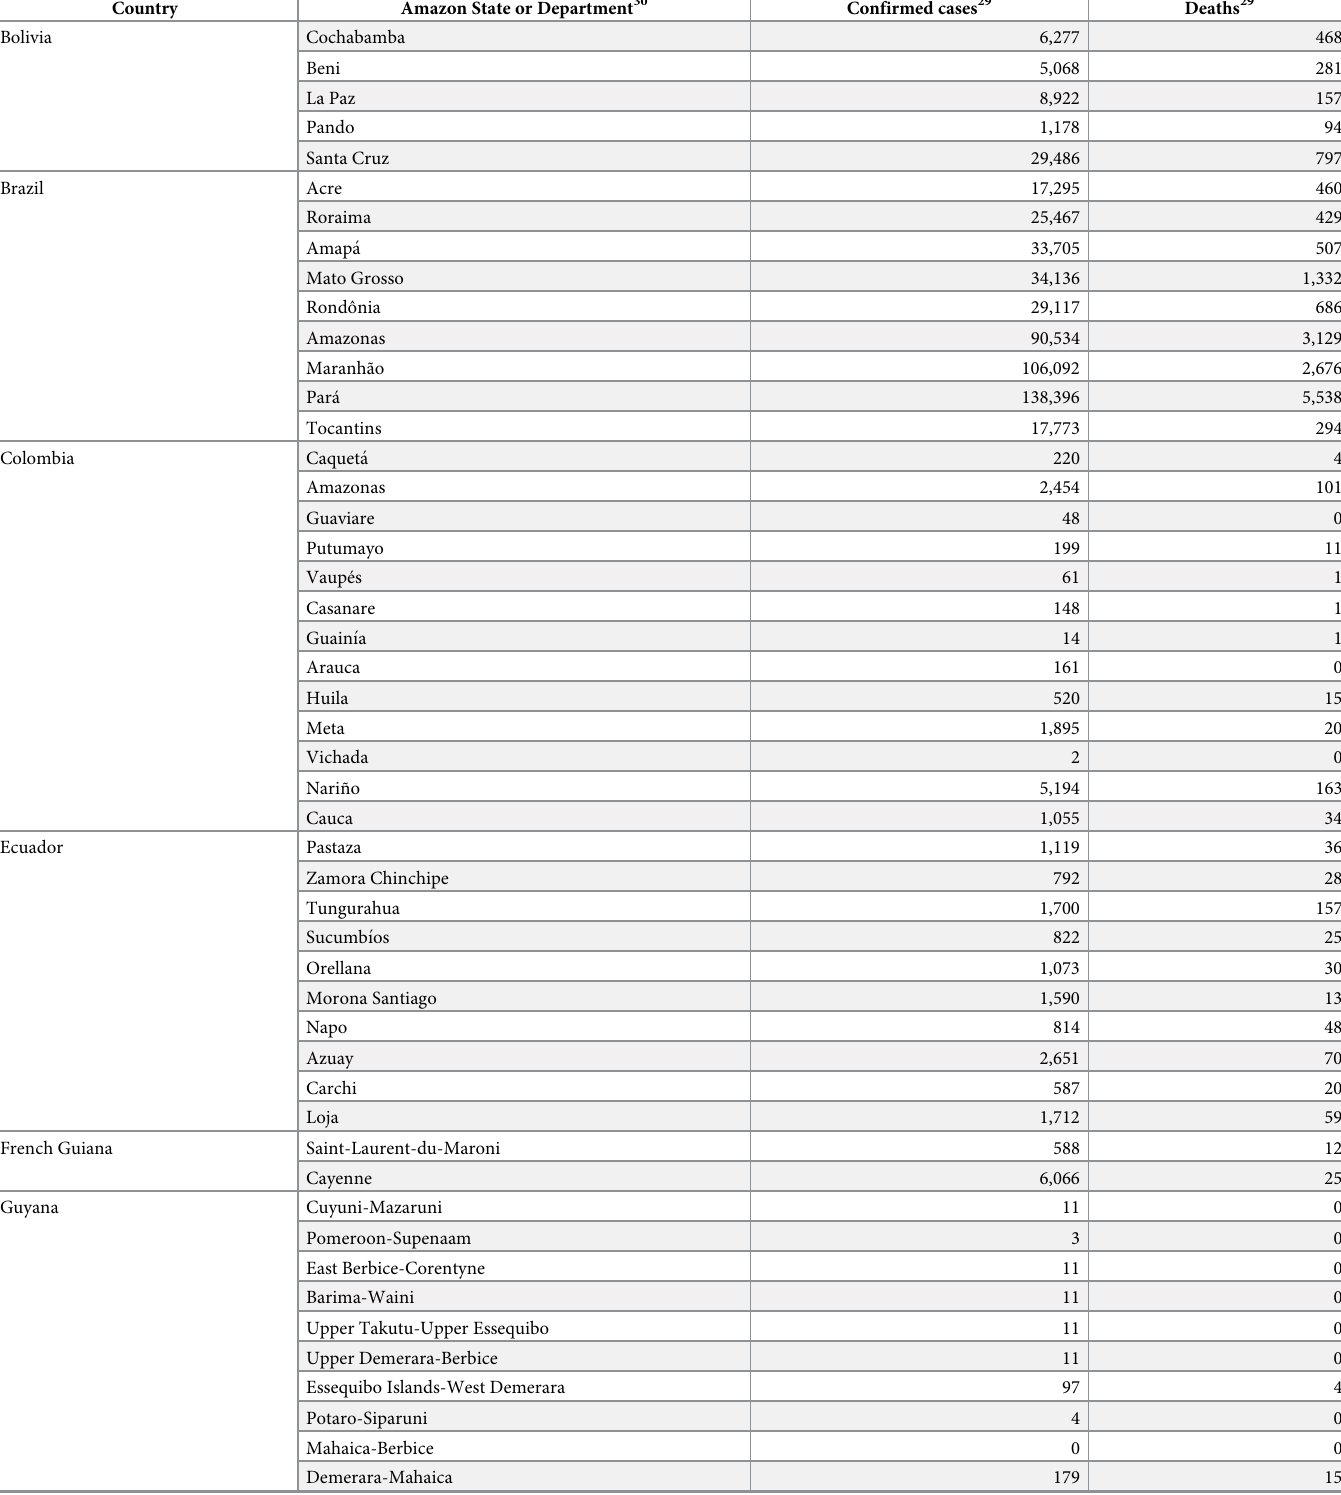
Table 1. Summary of COVID-19 cases in the Amazon region by state or department.